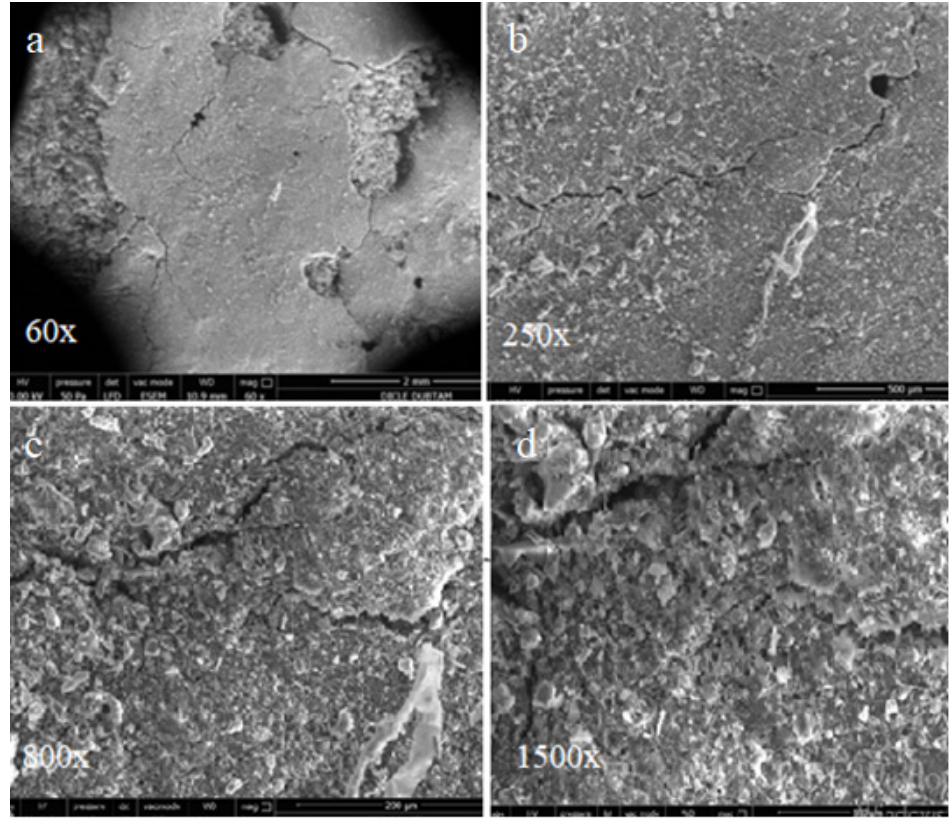
Figure 14. SEM images of control bar samples without replacement cured for 90 days in sulphate solution: ( a ) 60×; ( b )250×; ( c ) 800×; ( d ) 1500×.